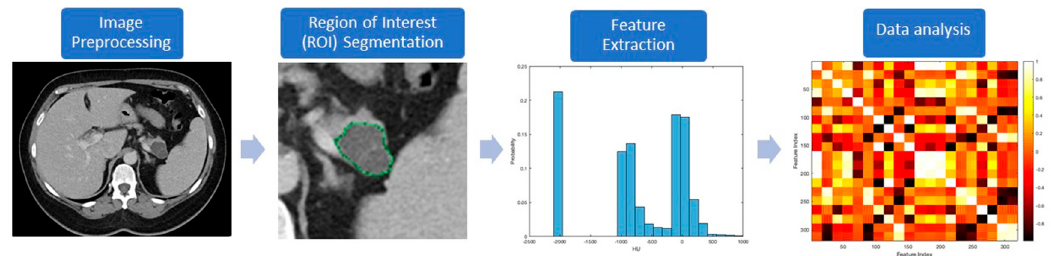
Figure 1. Diagnostic steps used in radiomics to evaluate a representative pancreatic cystic lesion (PCL).